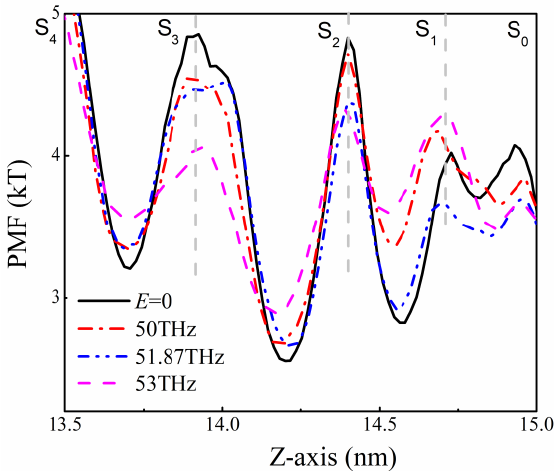
Figure 5. PMF at SF sites with and without the applied electric field at different frequencies, the solid black line is the case without the external field.